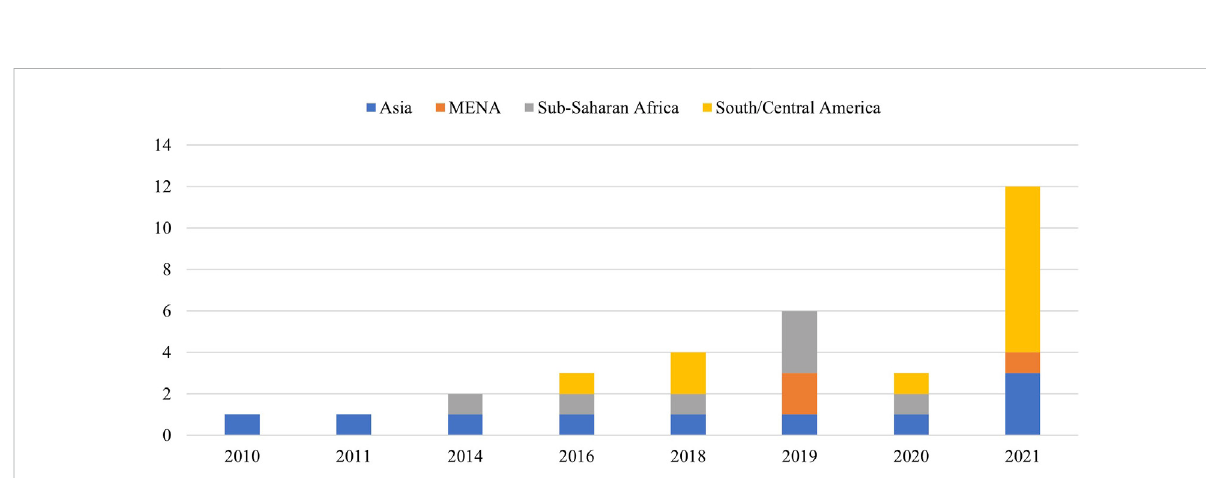
FIGURE 5 Trends in decarbonization research published on selected Global South countries. Source: Authors ’